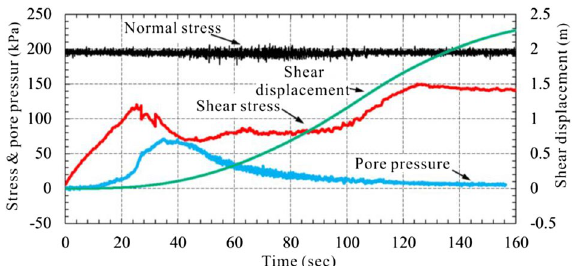
Figure 13. Shear characteristics of saturated